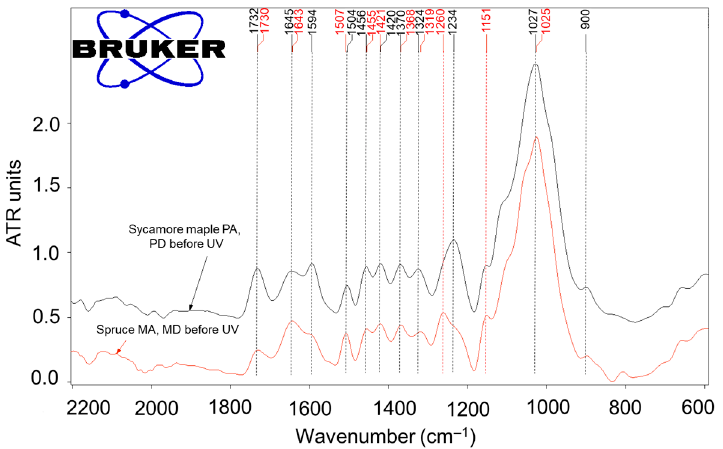
Figure 12. Comparisons of roughness profiles in the case of the PA and PD sycamore maple samples before and after UV exposure: ( a ) sample grade: PA; ( b ) sample grade: PD.